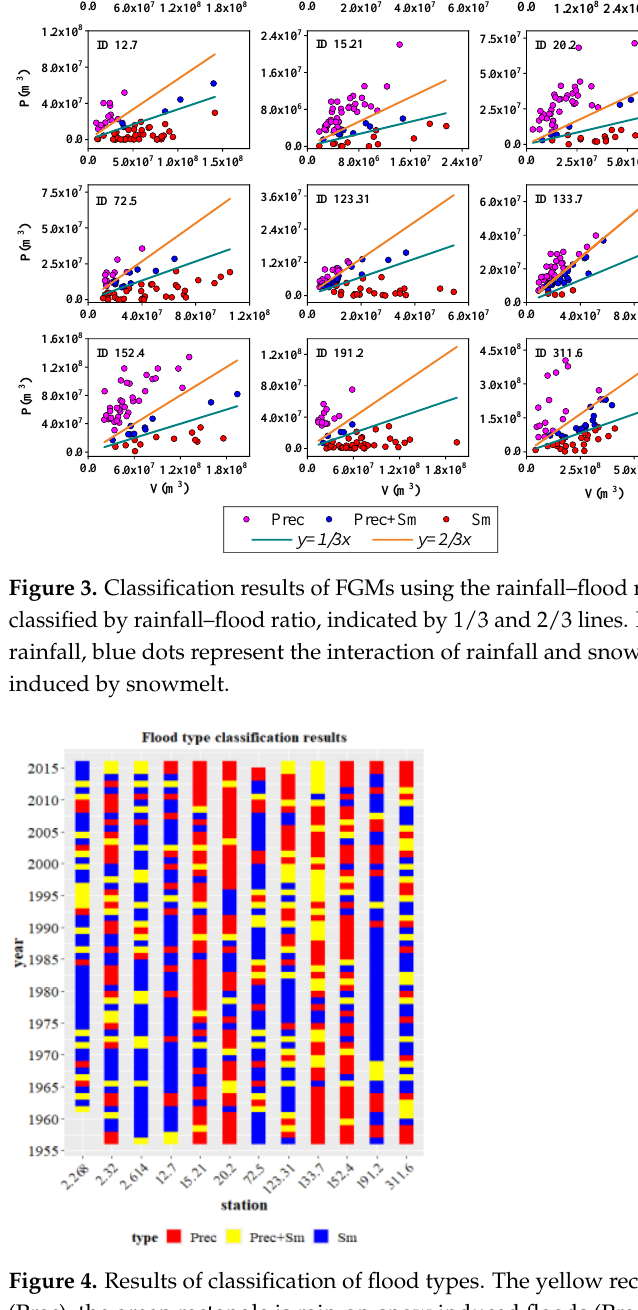
Figure 4. Results of classification of flood types. The yellow rectangle represents the rainfall floods (Prec), the green rectangle is rain-on-snow induced floods (Prec+Sm), and the blue rectangle is the snowmelt flood